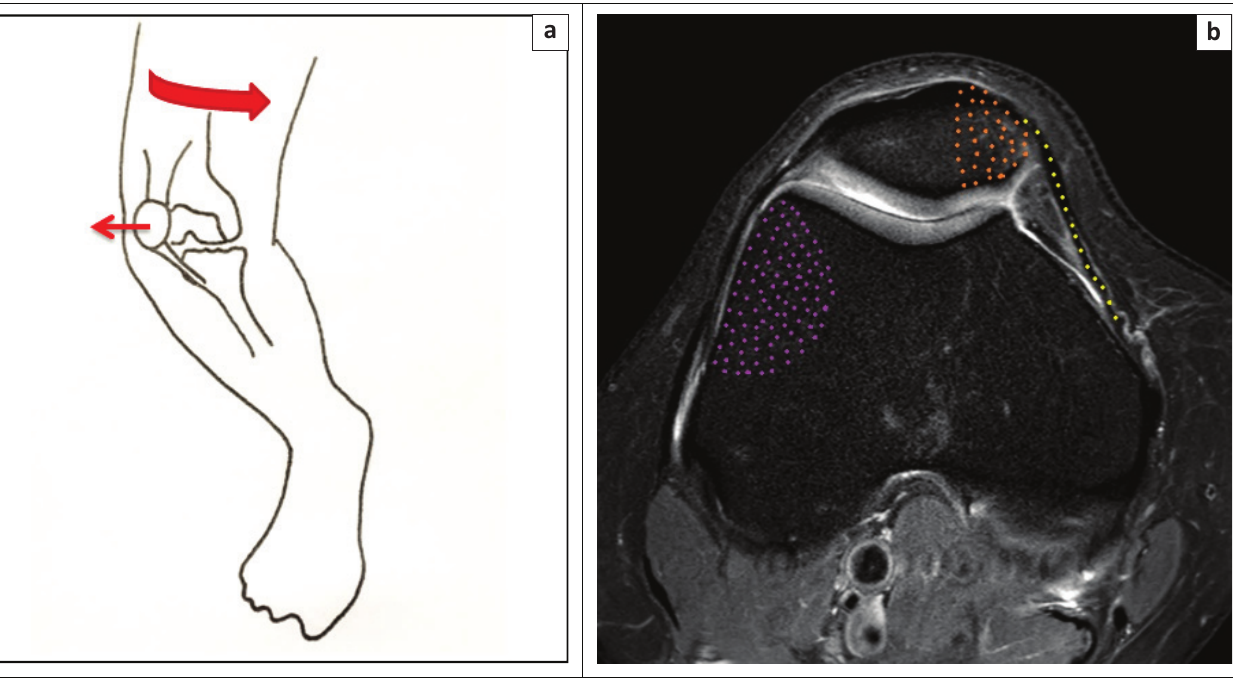
FIGURE 9: Patellar dislocation: (a) Schematic depicts flexion and internal rotation of femur on fixed tibia, (b) medial patella and lateral femur condyle impactions, and (c) and (d) show anterior cruciate ligament and MCL injury respectively, which may occur with sufficient